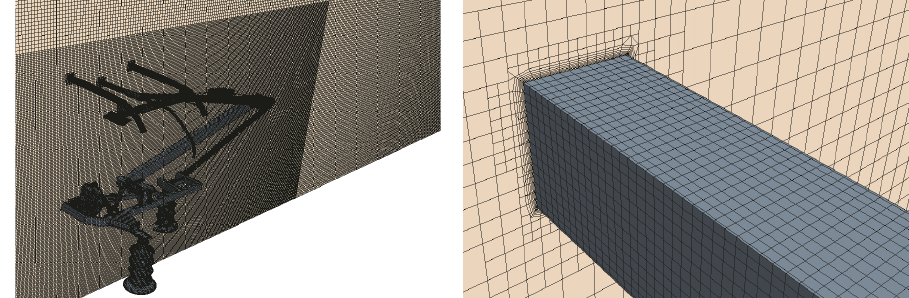
Figure 4: Surface meshes and boundary layer meshes of pantographs.